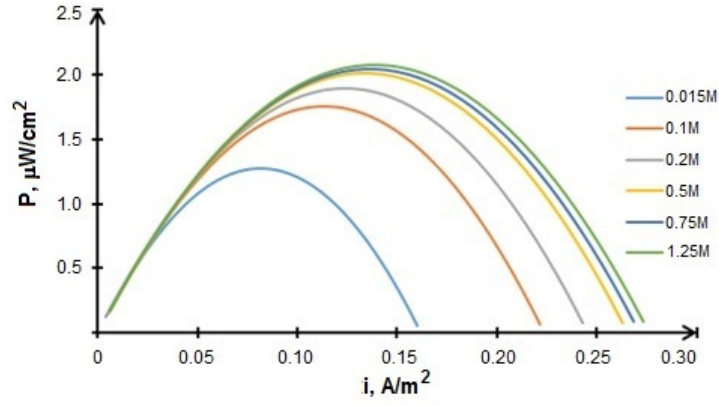
Figure 12. Calculated power density values vs. current density for MFC CoFe / CNT + BM at di ff erent fuel concentrations.